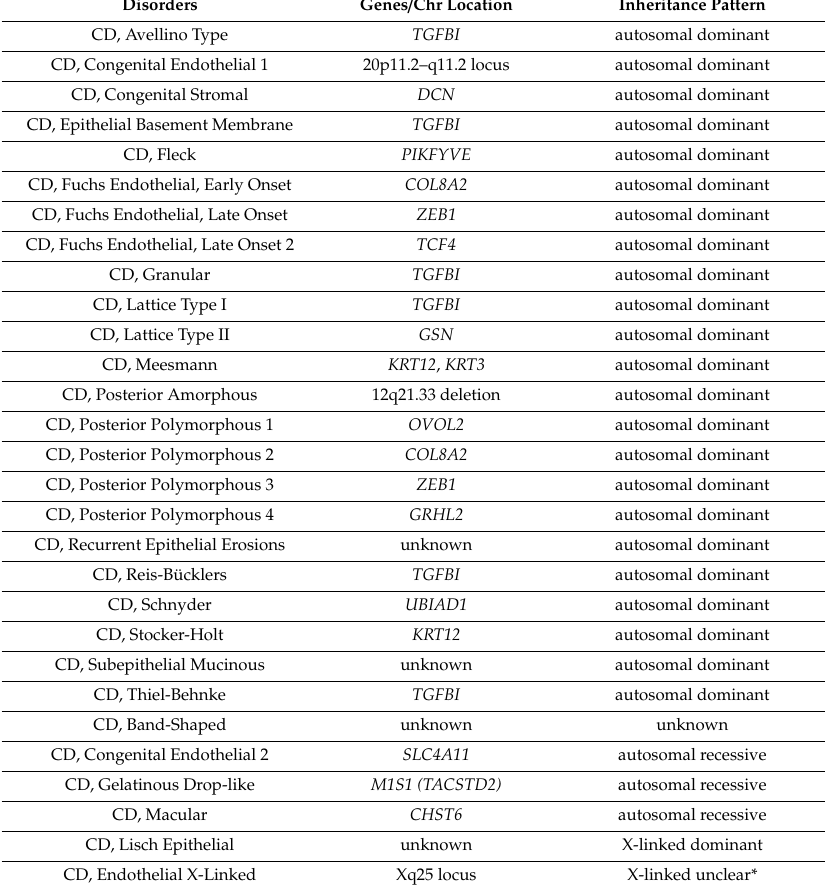
Table 1. Common corneal dystrophies along with associated genes and pattern of